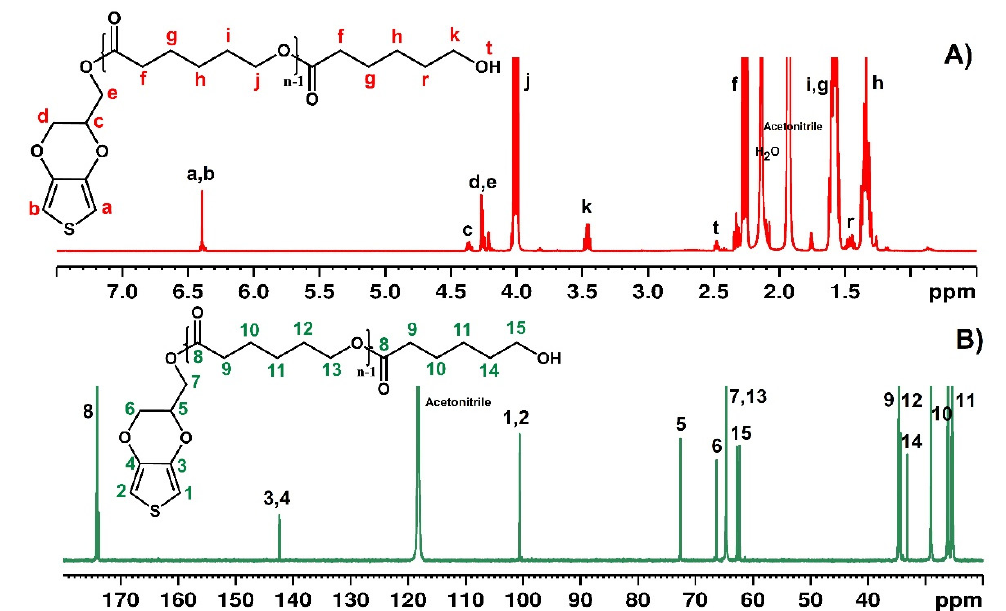
Figure 1. 1 H- ( A ) and 13 C- ( B ) NMR spectra of EDOT-PCL macromonomer in CD 3 CN.